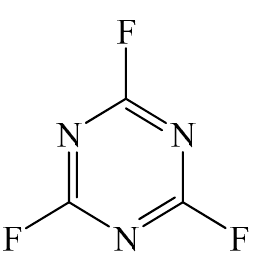
Figure 1. The chemical structure of 2,4,6-trifluoro-1,3,5-triazene ligand.